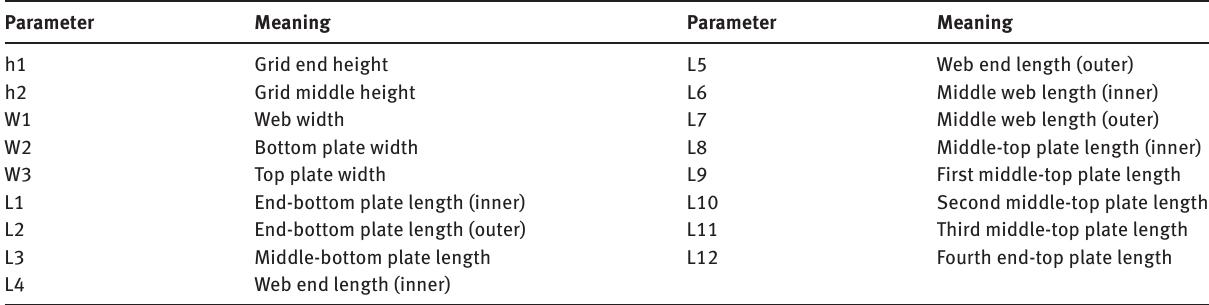
Table 2: The initial design parameters and their meanings.